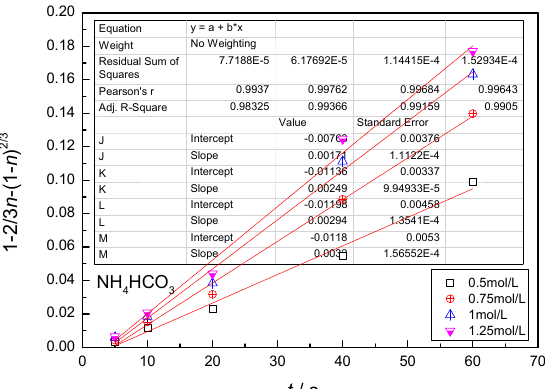
Figure 8. Linear relation between the leaching time and [1 − 2/3 η − (1 − η ) 2/3 ] (60 °C, particle size: 96–120 μ m, stirring rate: 90 rpm).